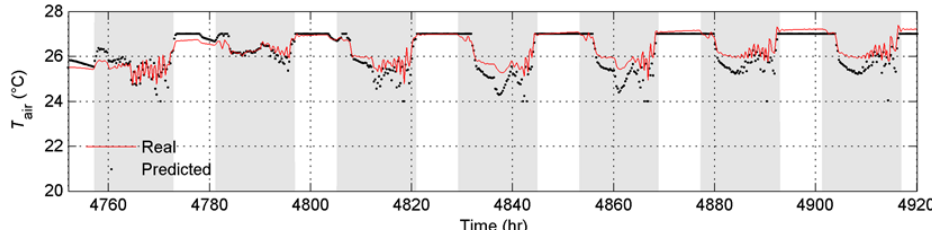
Figure 12. Comparison between actual indoor air temperature ( T air ) and its prediction in the MPC with OF G and PH of 18 h.